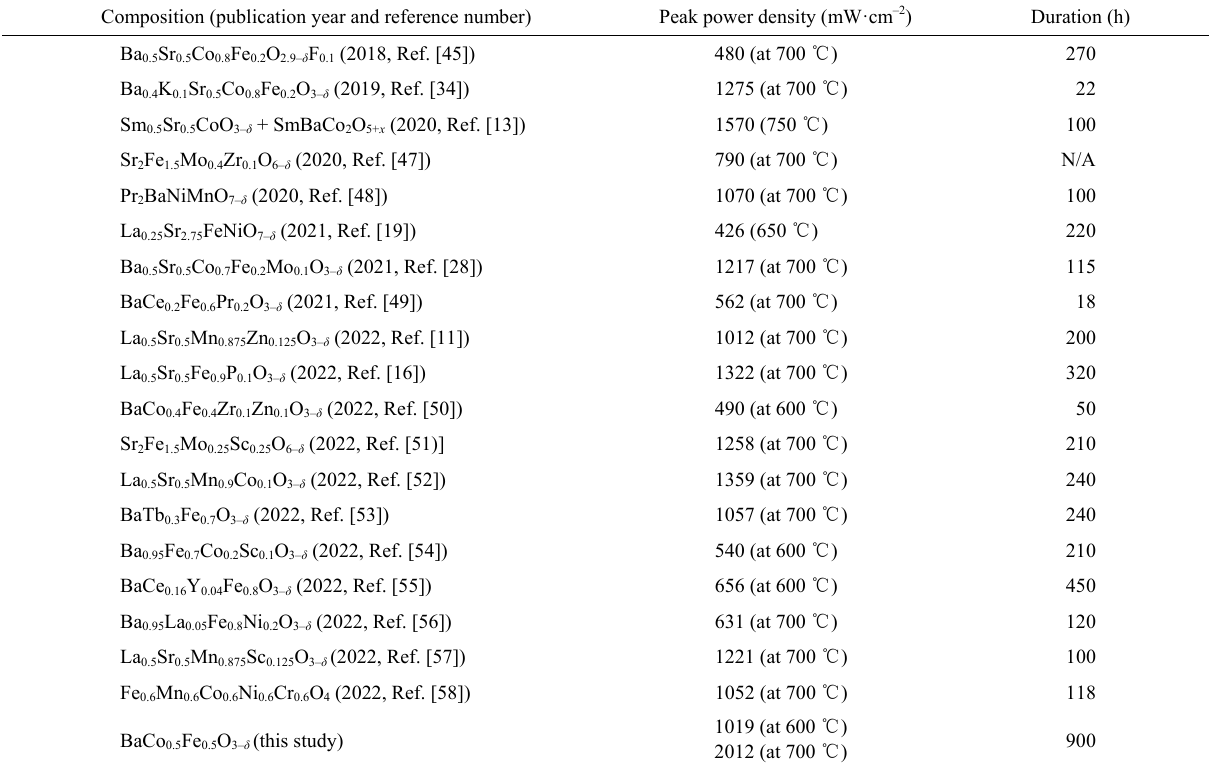
Table 1 Performance comparison between the current BCF cell with some high-performing H-SOFCs reported recently Composition (publication year and reference